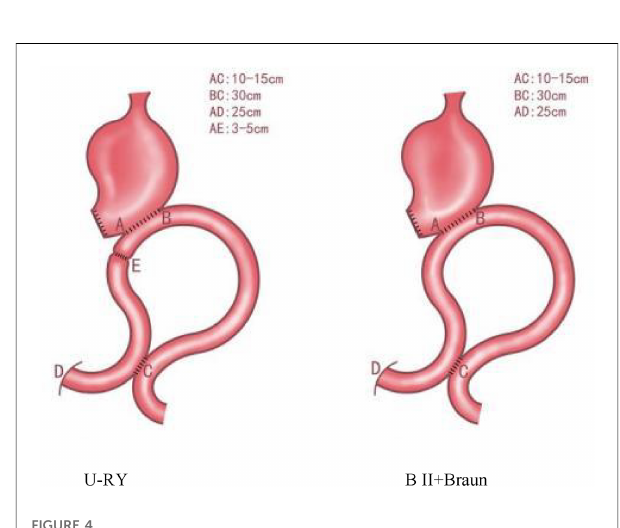
FIGURE 4 The two methods of digestive tract reconstruction are depicted.